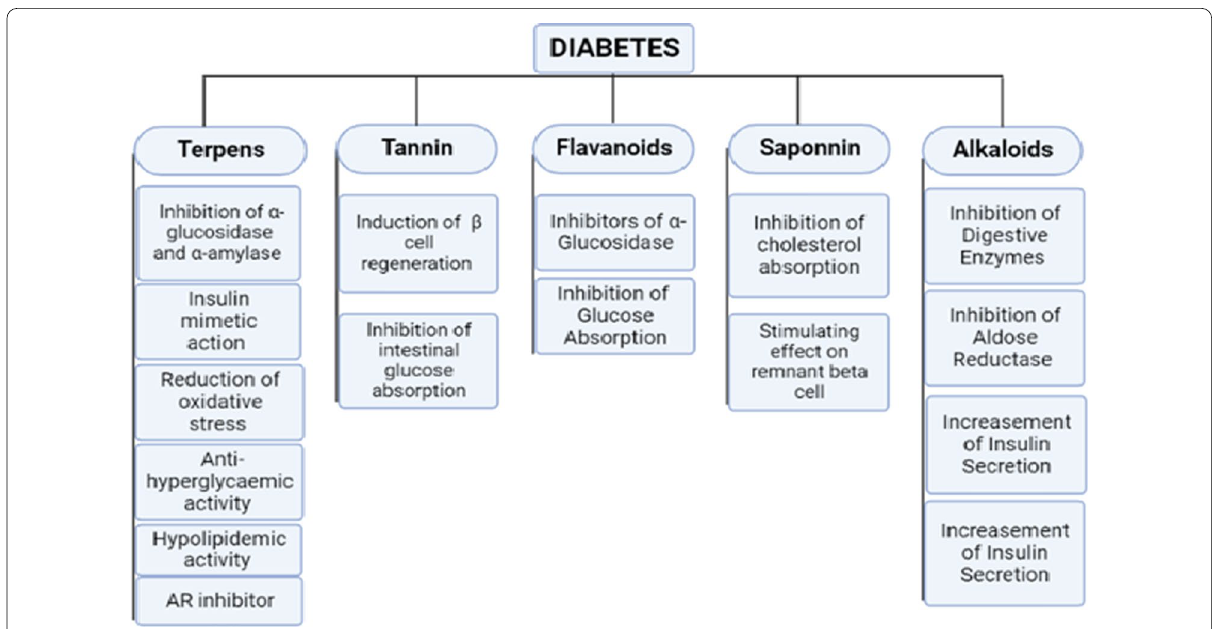
Fig. 1 Bioactive compounds potential for anti-diabetic activity with their mode of